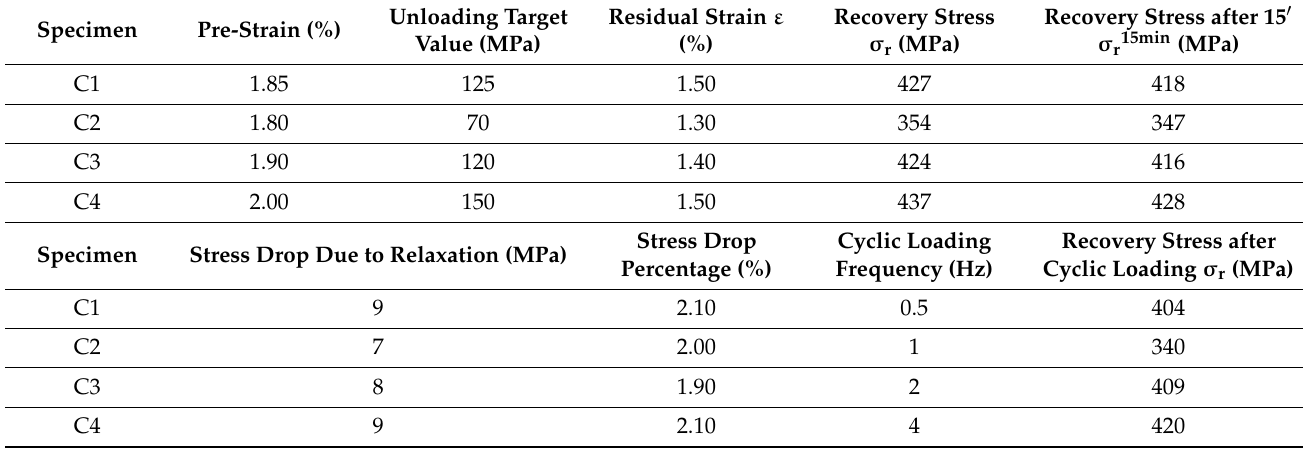
Table 1. Low-cycle fatigue test